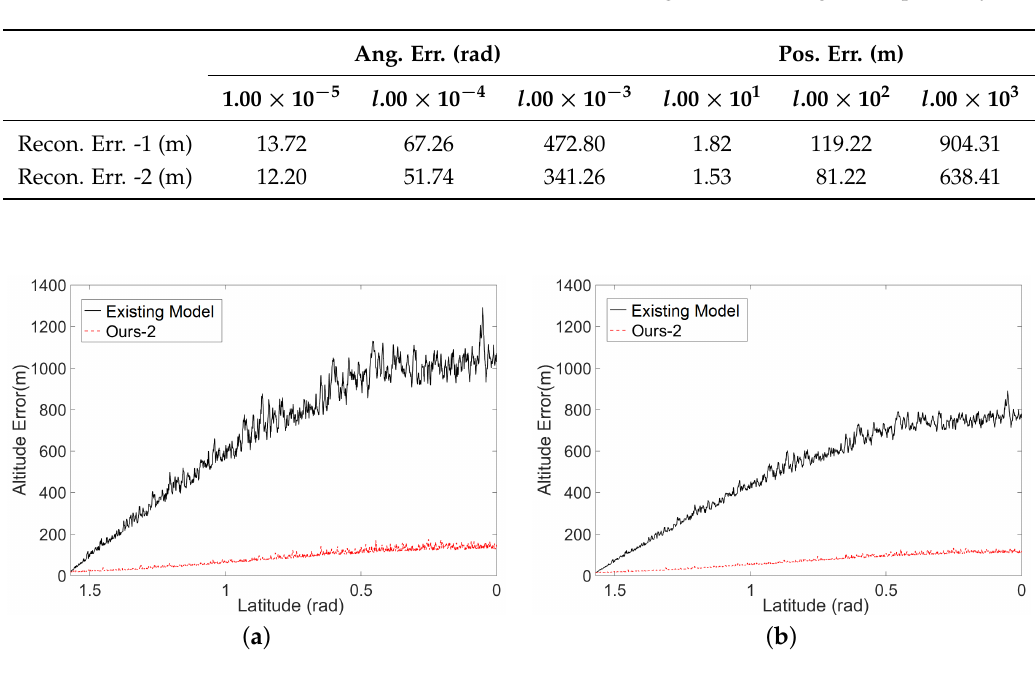
Table 4. The error of the reconstructed altitude data using forward intersection and based on the EOPs containing different levels of errors. Here, “Recon. Err. -1" and “Recon. Err. -2" indicate the errors of reconstructed altitude data based on the simulated data for Chang’E-1 and Chang’E-2 respectively.